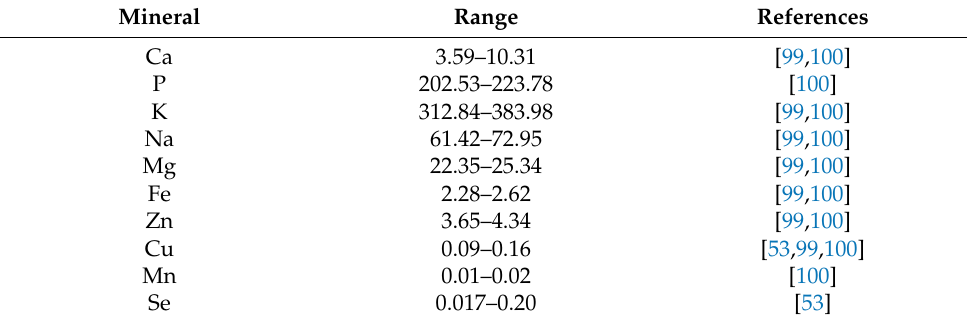
Table 6. Mineral content (mg/100 g of meat) of river buffalo meat.